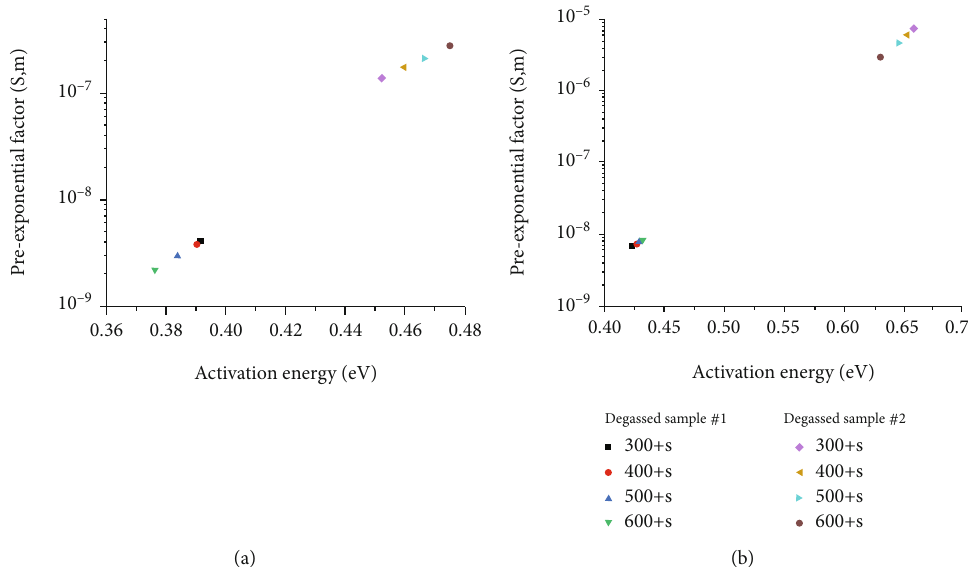
Figure 4: Plot of activation energy and preexponential factor for (a) two degassed LDPE samples and (b) two degassed XLPE samples as a function of measurement time. The number presented in the legend is the earliest time at which the current is counted for extraction of the Arrhenius